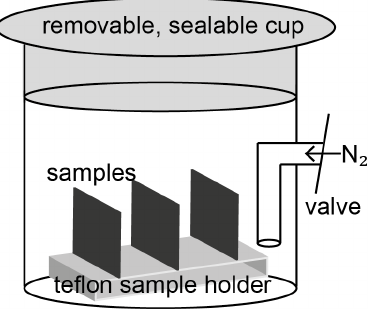
Figure 1. Schematic of the new reactor type developed for growing polymer brushes on flat